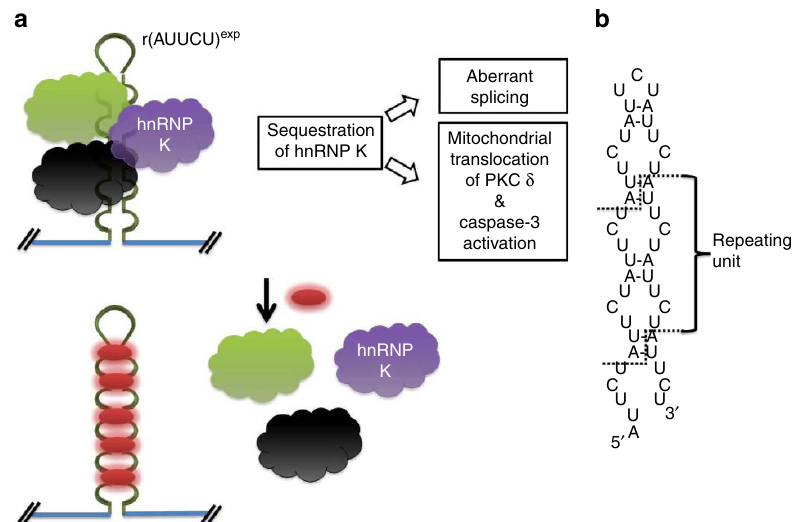
Figure 4 | Schematic of the pathogenic mechanism of SCA10 and a therapeutic approach by targeting the secondary structure of r(AUUCU) repeats. ( a ) r(AUUCU) exp , located within intron 9 of ataxin 10 ( ATX10 ) mRNA, sequesters proteins including hnRNP K. Sequestration of hnRNP K results in aberrant splicing of transcripts, mitochondrial translocation of PKC d and caspase-3 activation, leading to apoptosis (top). A possible therapeutic approach is using small molecules that bind r(AUUCU) repeats and displace sequestered proteins (bottom). ( b ) secondary structure of r(AUUCU) repeats with periodically repeating 5 0 AU/3 0 UA base pair steps.